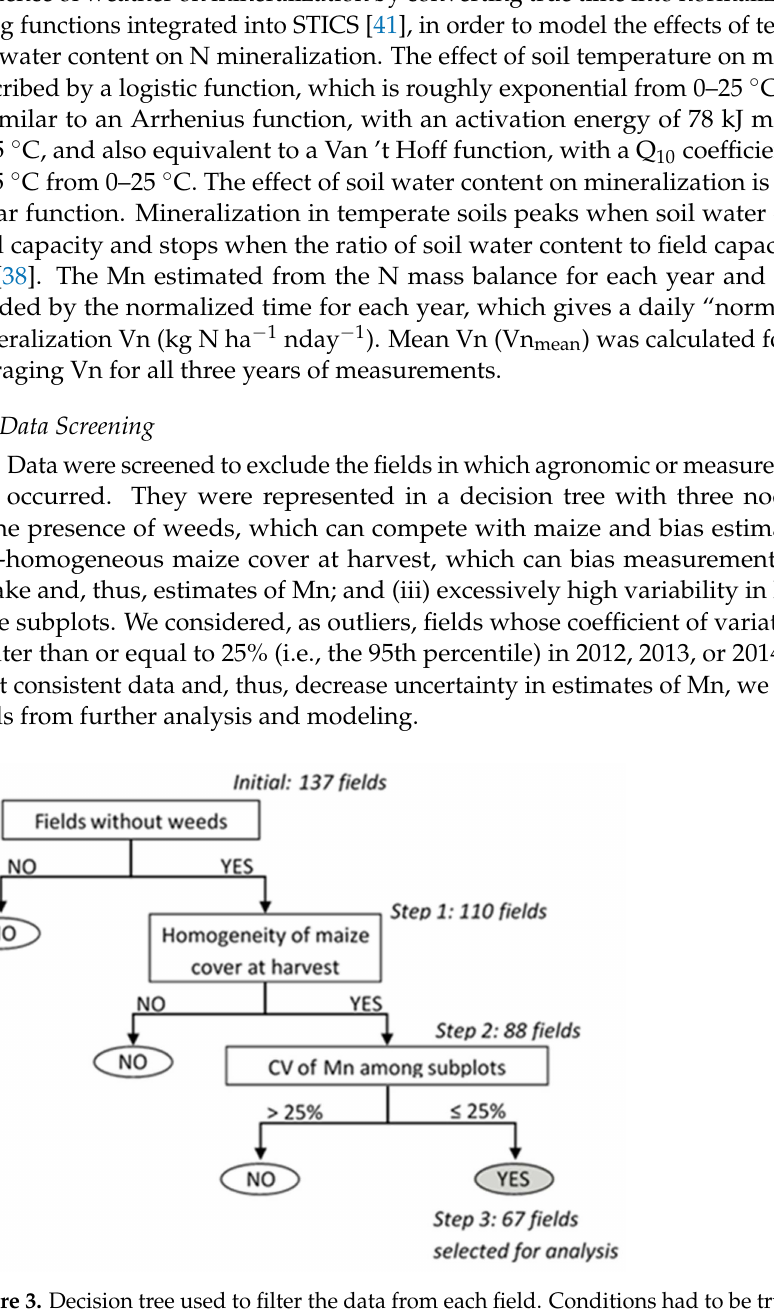
Figure 3. Decision tree used to filter the data from each field. Conditions had to be true for 2012, 2013, and 2014 to pass to the next step. CV: coefficient of variation, Mn: soil net nitrogen